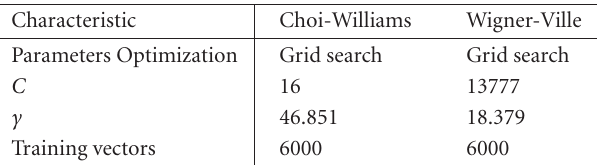
Table 2: Data of the SVM.